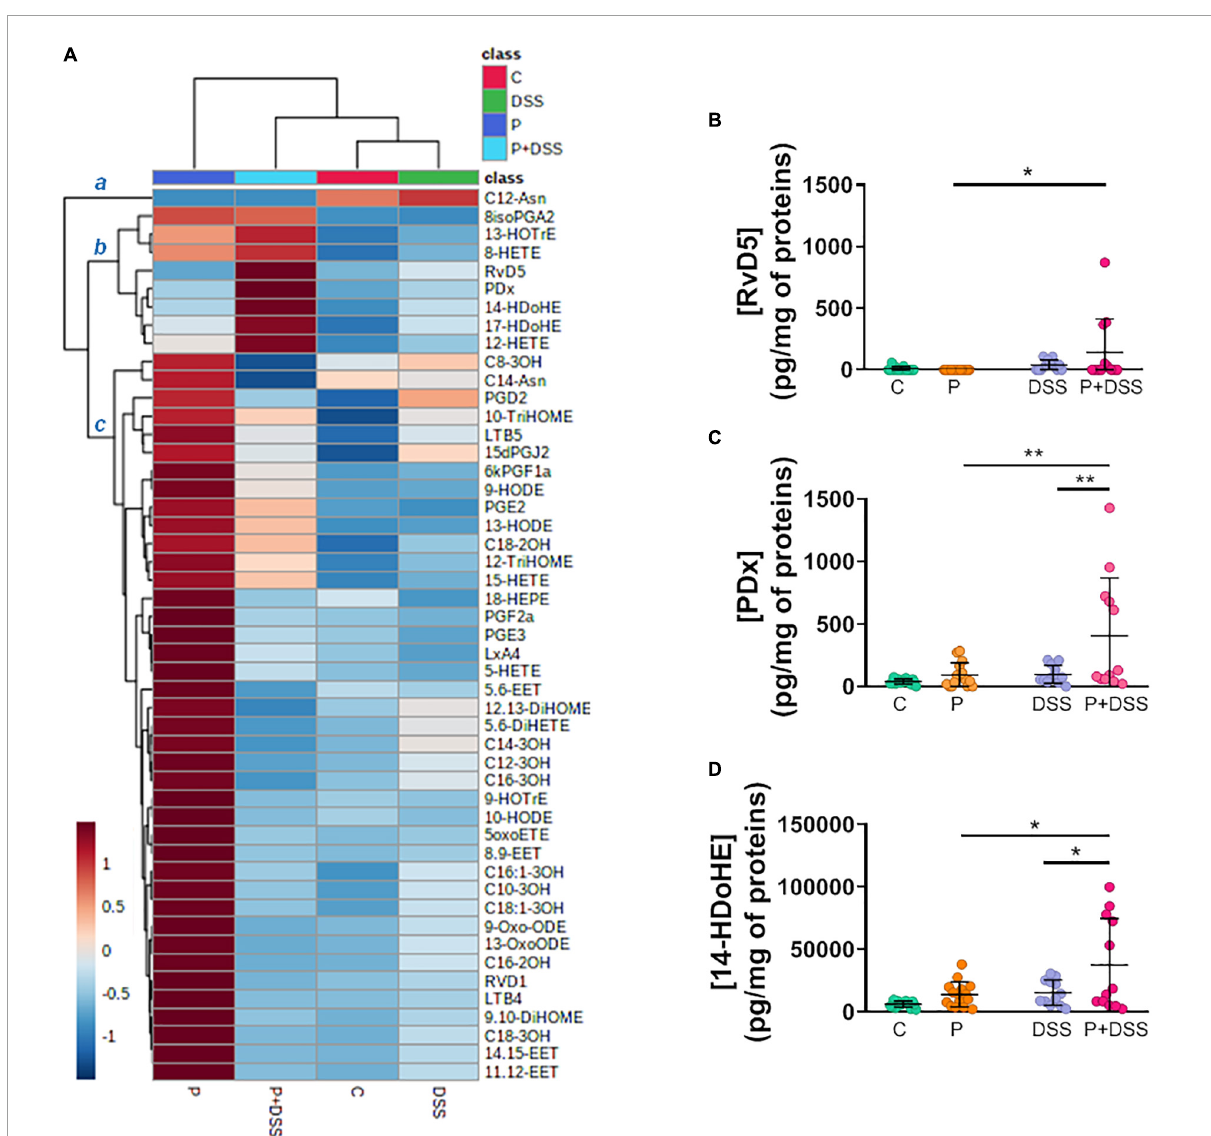
FIGURE4 Prebiotic administration to mothers remodels the bioactive lipid profiles and increases the concentrations of resolvin D5, protectin Dx, and 14-hydroxydocosahexaenoic acid after DSS treatment in distal colon. (A) Heatmap showing the mean normalised concentrations of 49 lipid mediators in the distal colon of each group of mice identified clusters of metabolites with similar variation in the P + DSS group. The colour gradient indicates the fold-change, with red and blue colours indicating up- and downregulation, respectively. (B–D) Analysis of the concentrations of lipid mediators identified in the upregulated b cluster: resolvin D5 (RvD5), protectin Dx (PDx), and 14-hydroxydocosahexaenoic acid (14-HDoHE), via two-way ANOVA, followed by Bonferroni’s post hoc comparisons tests: * p < 0.05, ** p < 0.01 (Prebiotics effect). Data represent the mean and standard deviation of the mean of 12–16 mice per